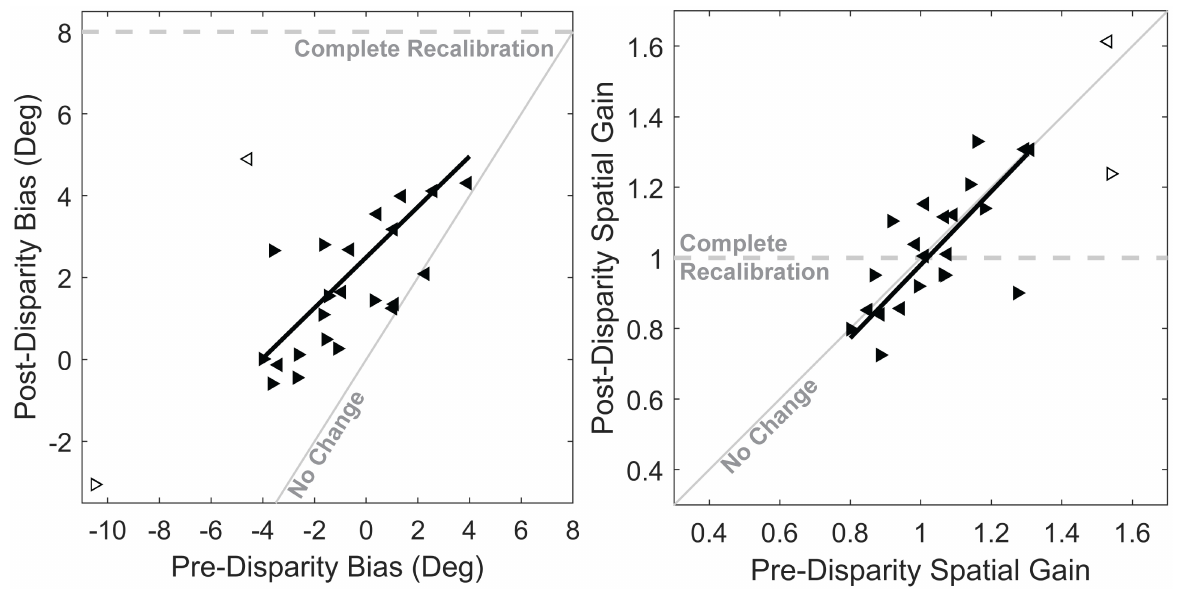
Fig 4. Pre- and post-disparity comparison of auditory bias and gain. left panel , Difference in bias between the pre-disparity and post-disparity blocks. Data from leftward and rightward disparity sessions are represented with leftward and rightward pointing arrows, respectively. The two hollow symbols represent one subject that was an apparent outlier, and was excluded from the line fit. Data from leftward disparity sessions was mirrored through the origin to overlay rightward data. The dashed gray line represents where responses would fall if subjects completely compensated for encoded disparity, the solid gray line indicates where responses would fall if no change in bias was observed, and the solid dark line is a linear best fit. right panel , Difference in spatial gain between the pre-disparity and post-disparity blocks.